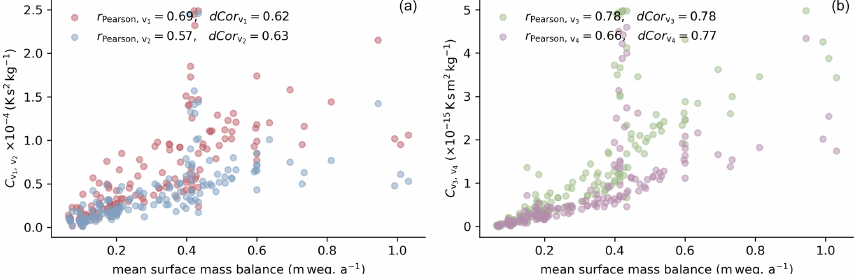
Figure 8. Factors obtained by optimization versus mean surface mass balance, calculated for 159 firn profiles from the forcing. (a) Best-fitting values for variants 1 and 2 (factors C v and C v , respectively). (b) Best-fitting values for variants 3 and 4 (factors C v 1 2 Linear correlation between the factors and mean surface mass balance is indicated by the Pearson correlation coefficient r Pearson , and the general correlation is indicated by the distance correlation